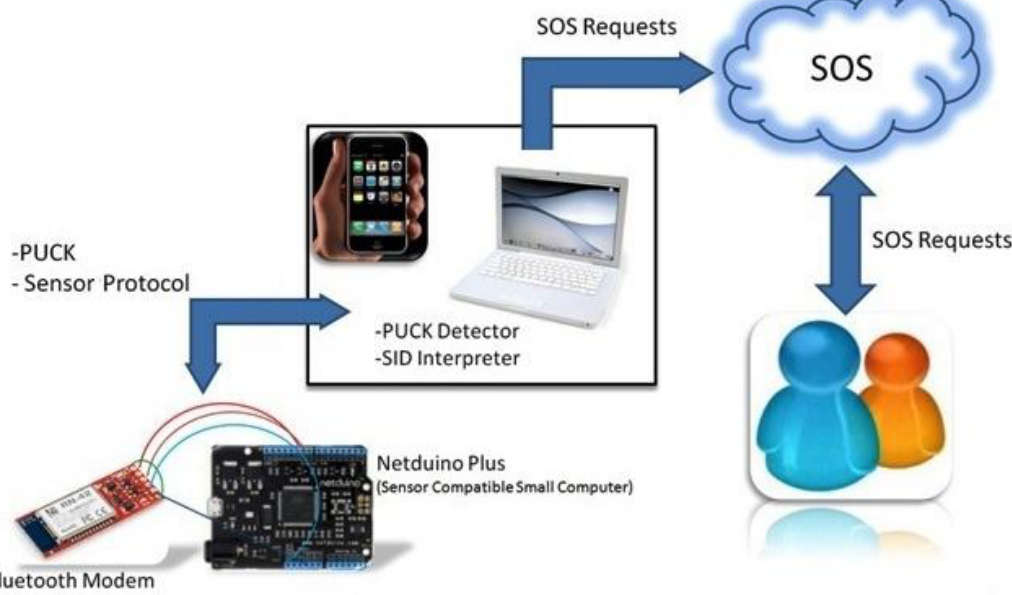
Figure 2. The overall workflow for accessing the sensor